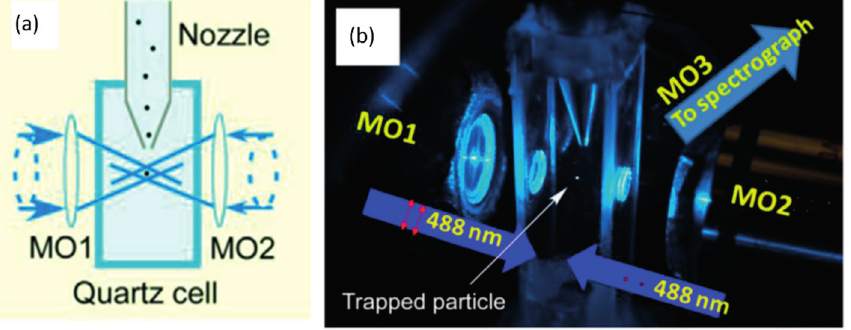
Figure 16. ( a ) LTRS studies on absorbing bioaerosols rely on a photophoretic trap to hold a particle in the low intensity region formed between two counter-propagating hollow beams; ( b ) Photograph of an experimental photophoretic LTRS system in which an aerosol delivery nozzle introduces particles into the photophoretic trap for on-line particle characterization [23]. (With permission from